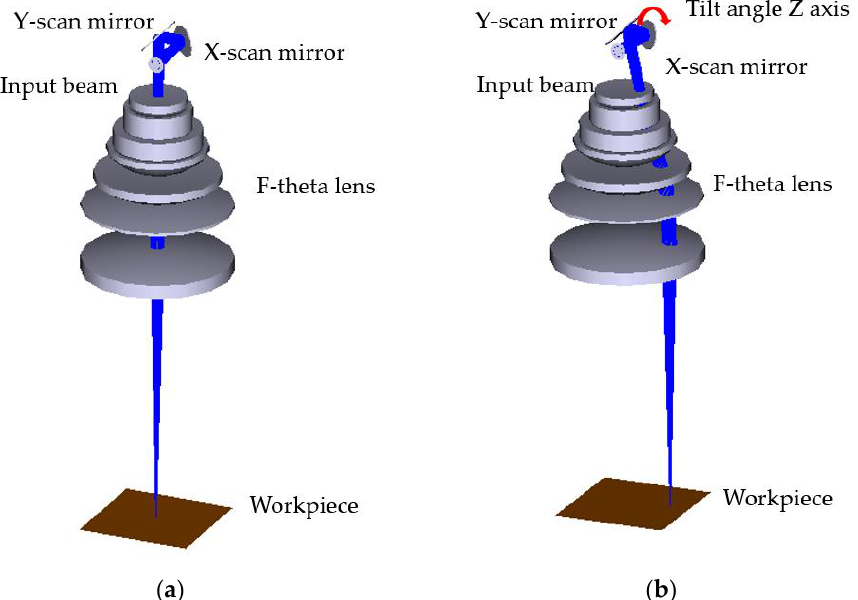
Figure 1. The simulated image of ( a ) an ideal 2D scanning system and ( b ) a commercial 2D scanning system with an X-scan mirror tilted to the Z axis at an angle of 15 degrees with the deflection of beam position.